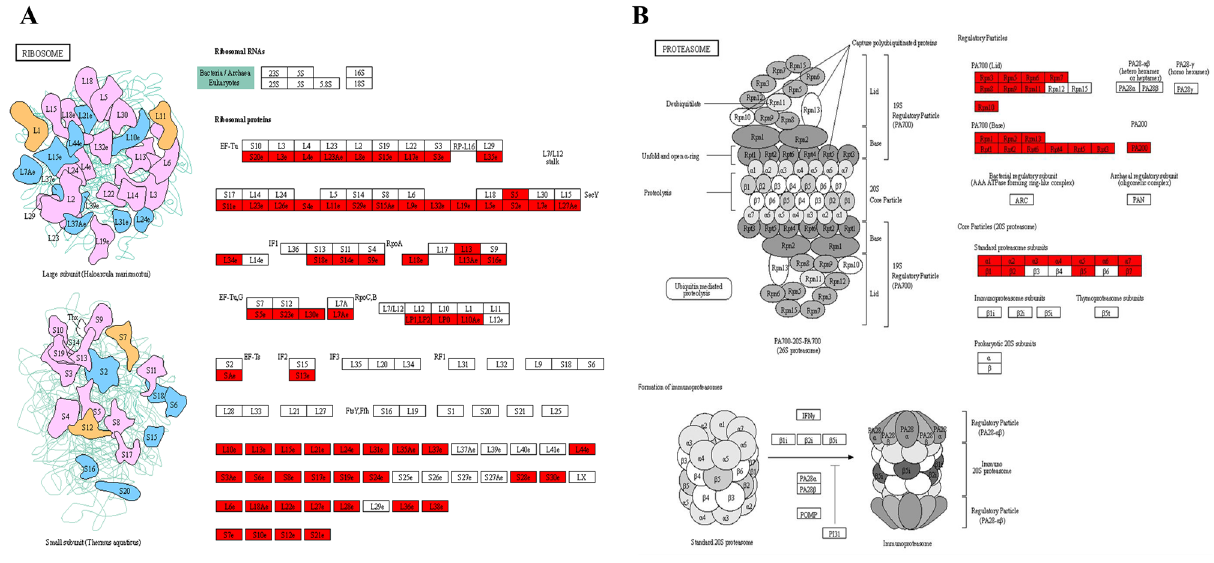
Figure 4. Representative significantly enriched protein metabolism related KEGG pathways. ( A ) Ribosome. ( B ) Proteasome. The Khib proteins are labeled in